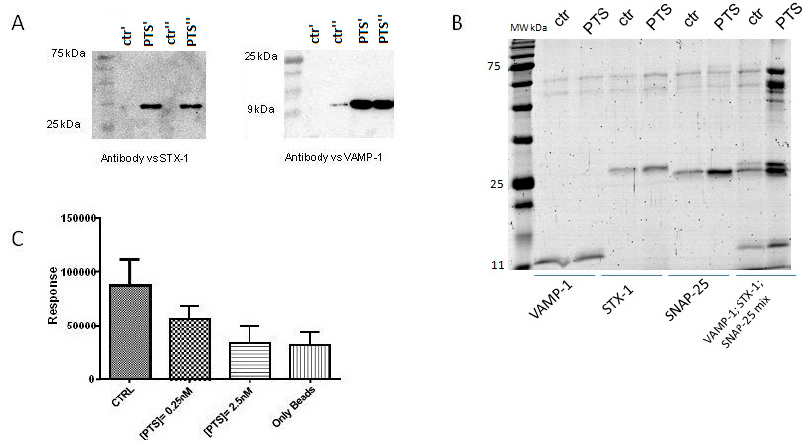
Figure 3. Panel A : Immunoblotting analysis of PTS AP experiments, performed in duplicate (ctr’ / PTS’ and ctr” / PTS”) and loaded on the same SDS PAGE, showing the enrichment of STX-1 and VAMP-2 on INS-1 832 / 13 cell lysates. Panel B : In vitro PTS AP experiments carried out in duplicate on samples containing solely VAMP-2, STX-1 SNAP-25, respectively, or their 1:1:1 mixture, showing the capability of PTS to fish out the complex more than single proteins. Panel C : Alpha Screen results showing PTS interference with SNAP-25-VAMP-2-STX-1 complex formation, mean ± SD of four replicates is shown.